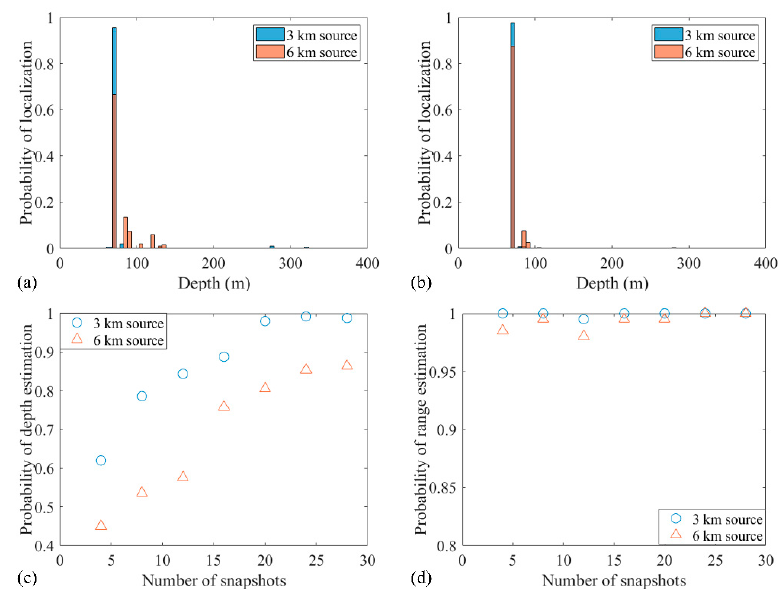
Figure 8. Effect of the number of snapshots on the localization for the two-source case with the signal-to-noise ratio (SNR) = 5 dB and the source 1 to source 2 ratio (SSR) = 5 dB: ( a ) 14 snapshots; ( b ) 28 snapshots. Probabilities of ( c ) depth estimation and ( d ) range estimation with different snapshots.